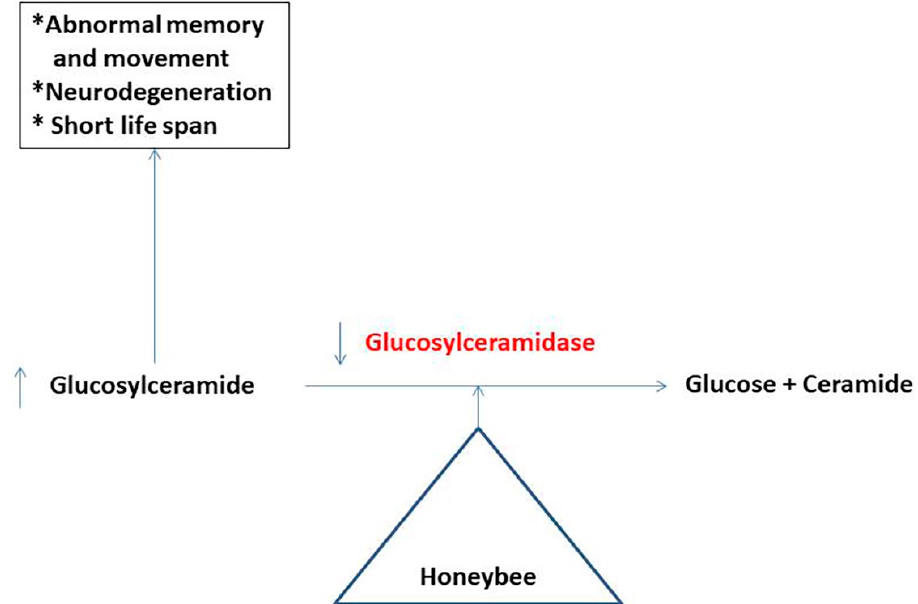
Figure 3. Glucosylceramidase in honey and its effect on the honeybee’s health [8,80].